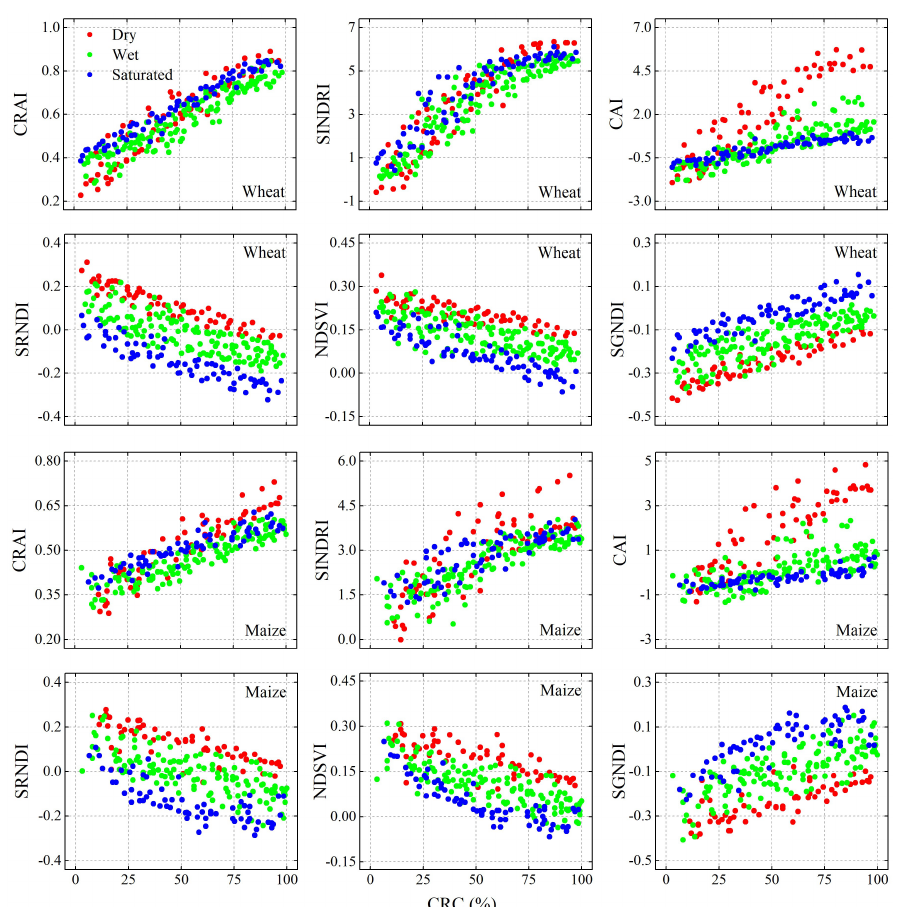
Figure 6. Correlation between spectral indices and crop residue cover for various crop residue moisture contents (laboratory-based calibration dataset: n = 279 for wheat and n = 261 for maize). Note: All laboratory-based calibration datasets were divided into three moisture groups (dry, wet, and saturated), and each groups includes four soils (paddy soil, black soil, meadow soil, and brown soil).